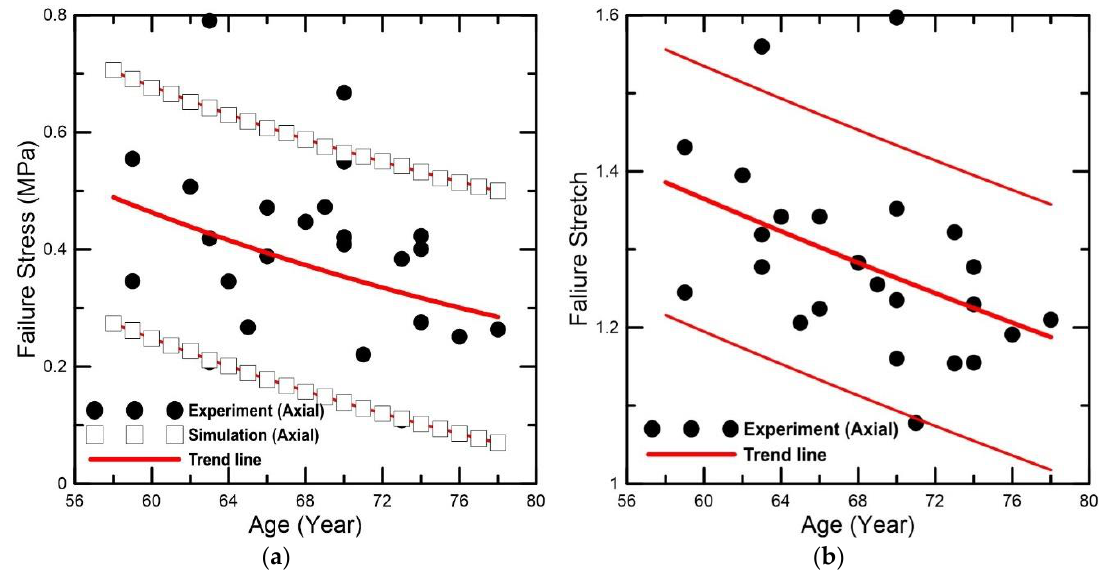
Figure 6. Experimental and simulation results, trend lines for ( a ) failure stress and ( b ) stretch.